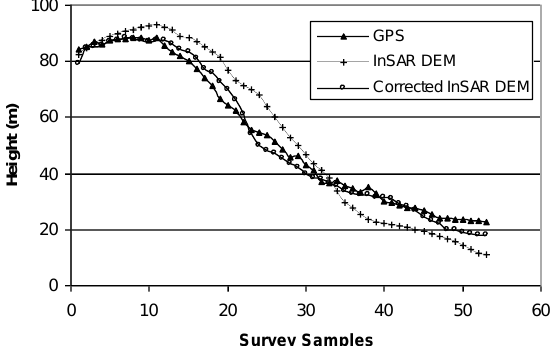
Figure 2. Three cross profiles along the maximum height difference. The graph shows the height difference (vertical axis) against the distance intervals (horizontal axis). For InSAR DEMs assessment, the GPS point measurements of region’s topography prior and post SAR data acquisitions were used. The samples with 3-dimensional accuracy better than 5 centimeters are only used for this procedure in Surfer v.8 software. The two GPS derived surfaces are then subtracted for elevation difference surface generation figure4. This surface called GPS DEM is used for validation of InSAR DEM modification